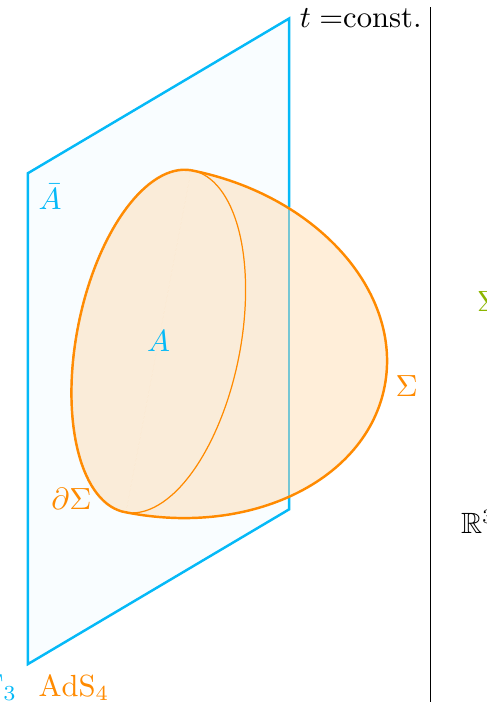
Figure 3 . The doubling of the minimal surface (cid:6) is achieved by gluing a copy (cid:6) 0 so that they are